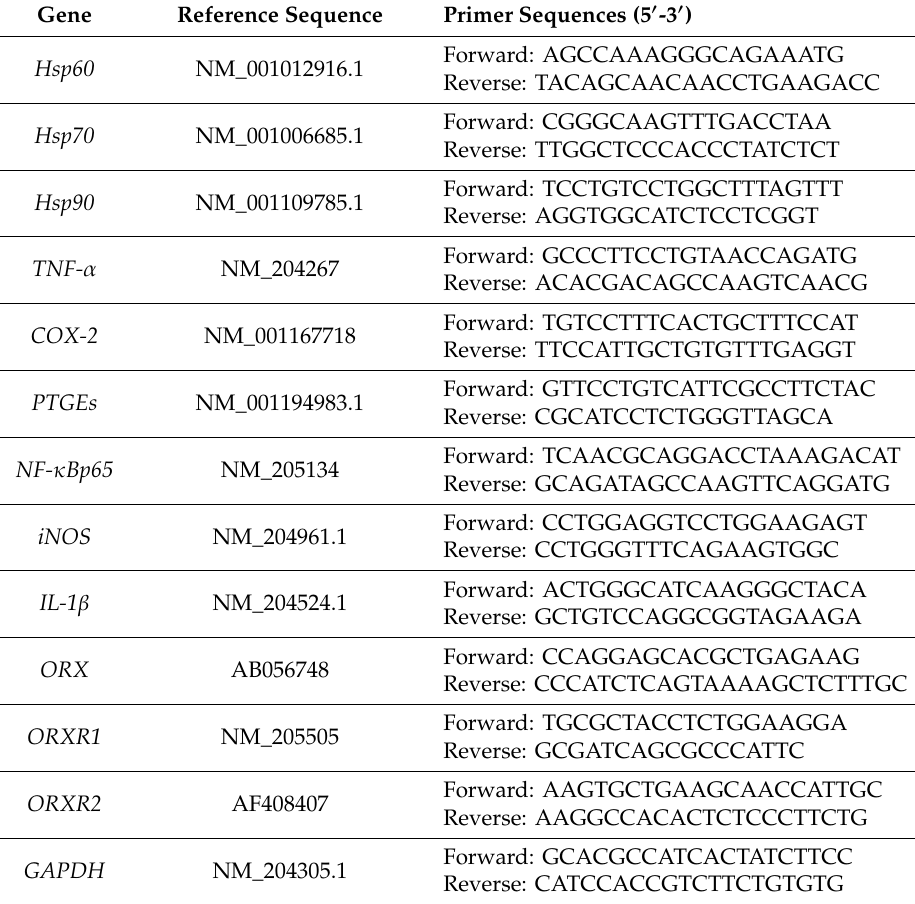
Table 1. Primer sequences for quantitative real-time